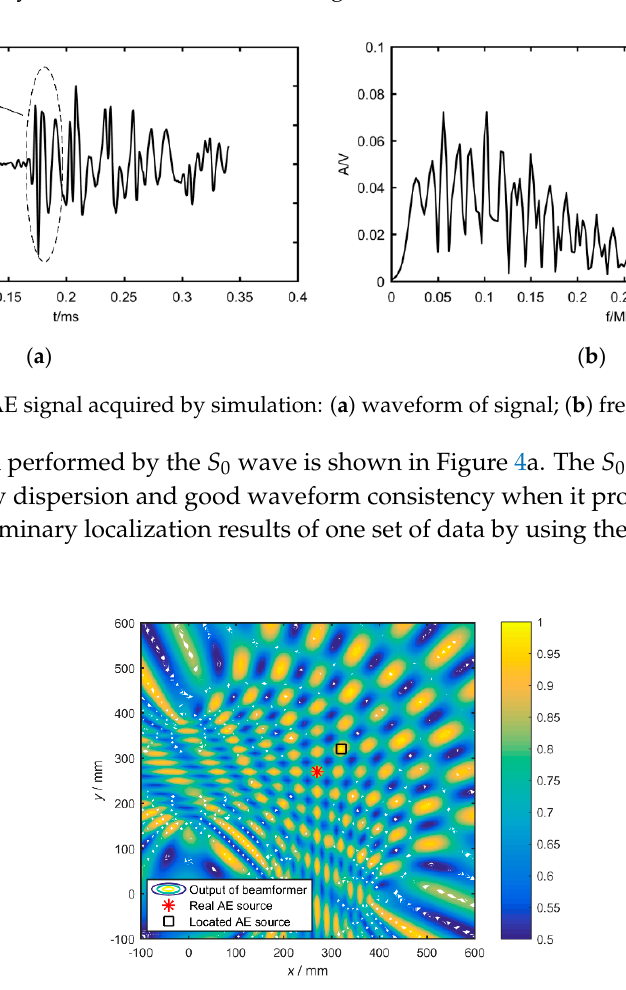
Figure 5. The preliminary localization determined by the S 0 wave.